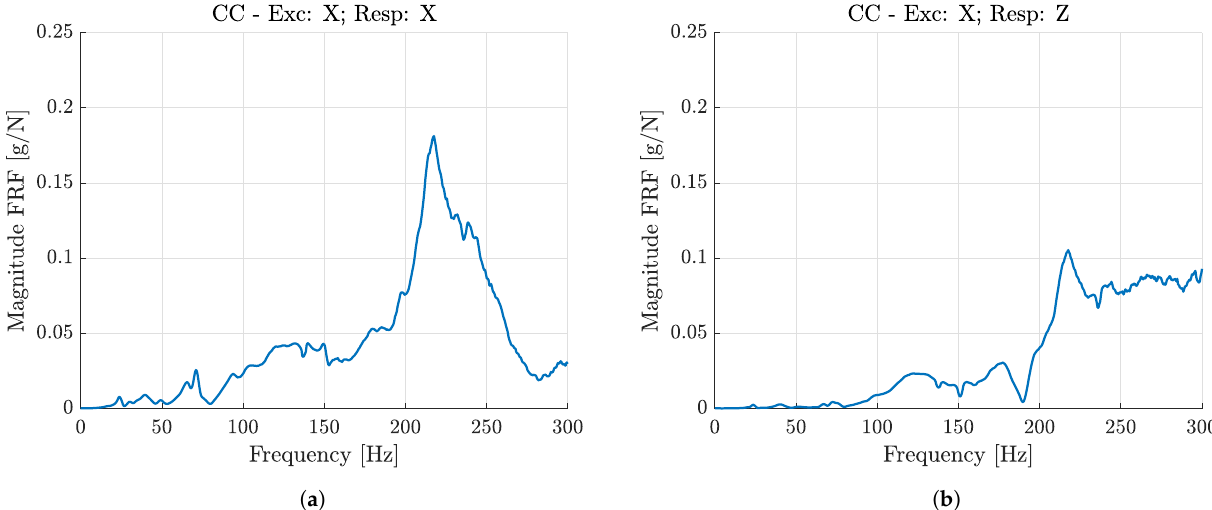
Figure 13. FRFs with the cutting head in the center-center (CC) position. Response in ( a ) X direction and ( b ) Z direction.